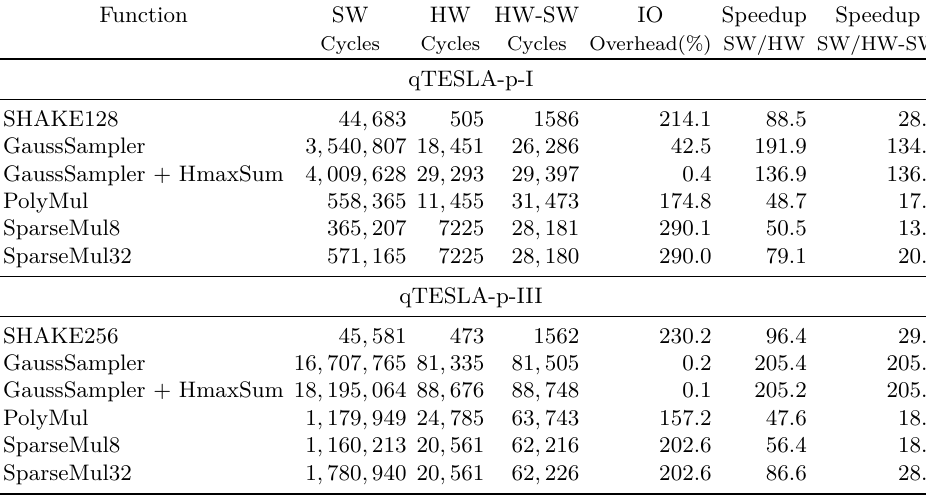
Table 8: Performance of different functions on software, hardware and HW-SW co-design. The “Speedup” columns are expressed in terms of cycle